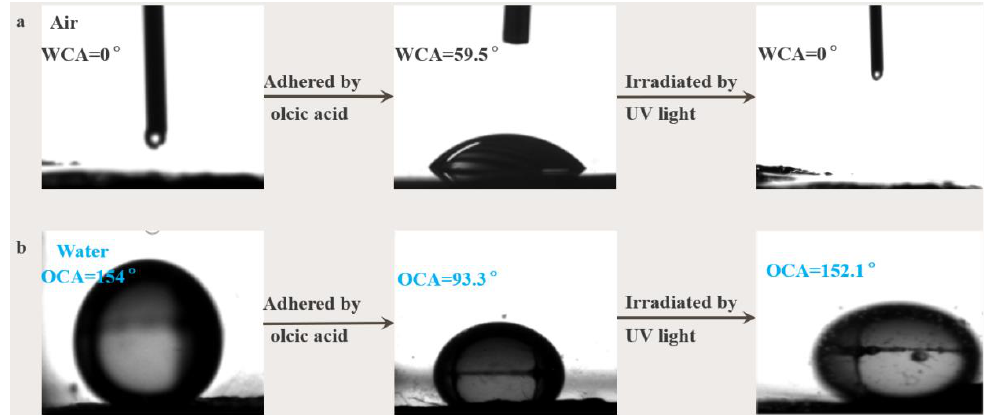
Figure 9. ( a ) The change of water contact angle (WCA) of the BTA by UV light. ( b ) The change of oil contact angle (UOCA) of the BTA by UV light.